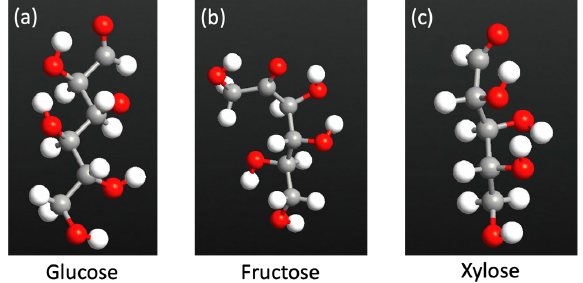
Figure 2. Atomic structure of each of the sugar molecules: glucose ( a ), fructose ( b ), and xylose ( c ). Color code: oxygen—red, carbon—gray, and hydrogen—white.